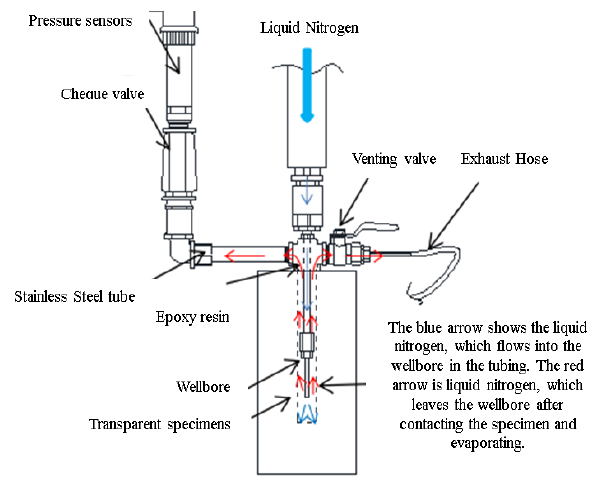
Figure 2. Schematic of the liquid nitrogen low-pressure impact experiment.